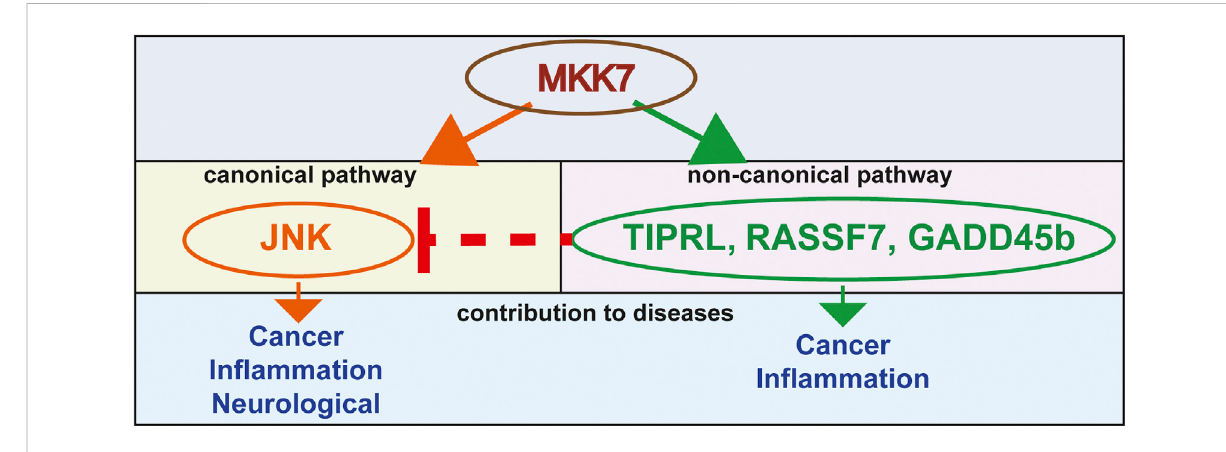
FIGURE 1 A model of MKK7-mediated mechanisms that contribute to a variety of